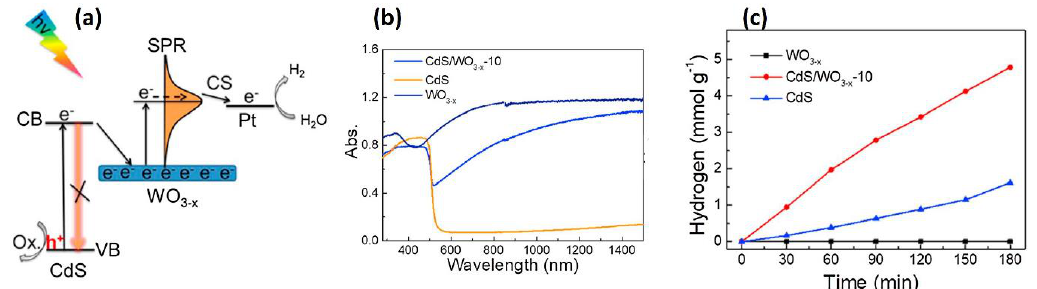
Figure 4. ( a ) Graphic illustration of charge transfer for CdS / WO 3 − x composite; ( b ) DRS spectra of WO 3 − x , CdSandCdS / WO 3 − x − 10 ; ( c )hydrogengenerationforCdSnanowires, WO 3 − x andCdS / WO 3 − x − 10 composites in 20 vol% lactic solution under illumination. Reproduced from [31], with permission from Elsevier,